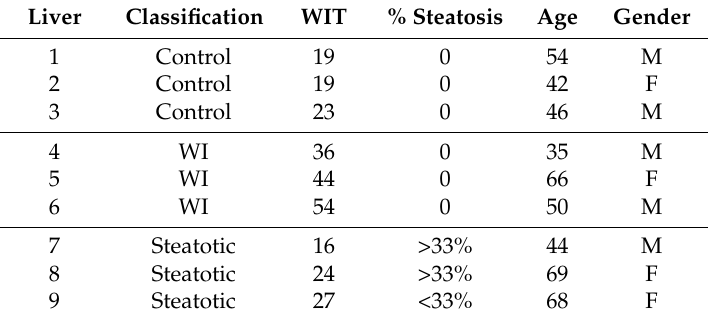
Table 1. Donor characteristics of each discarded liver used for subnormothermic machine perfusion (SNMP). The Warm Ischemia Time (WIT), percent macrovesciular steatosis, age and gender of the donor are listed.